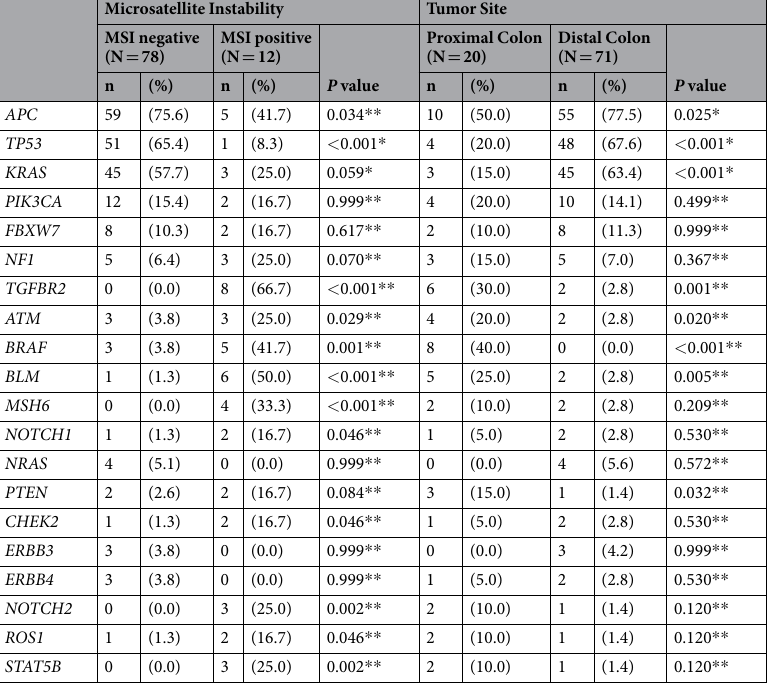
Table 1. Mutation profile of the most frequently altered genes in our study population by microsatellite instability status and tumor site. * Chi-squared test; ** Fisher Exact Test; MSI: microsatellite